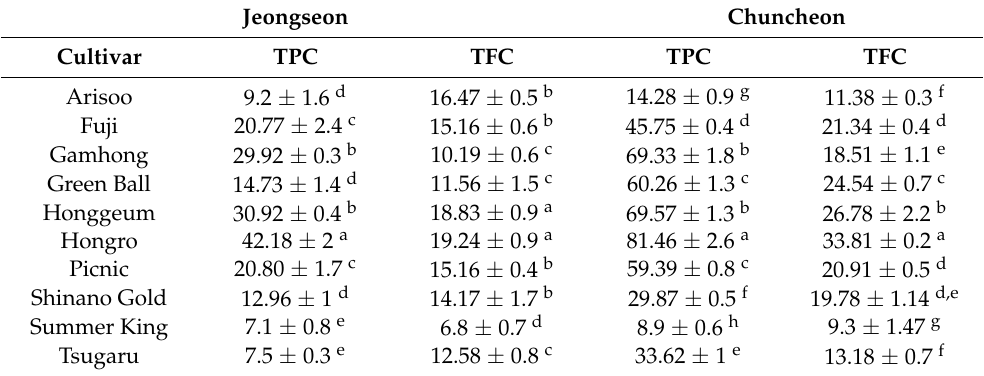
Table 2. Total phenolic and flavonoid contents in unripe apple fruits from two locations.